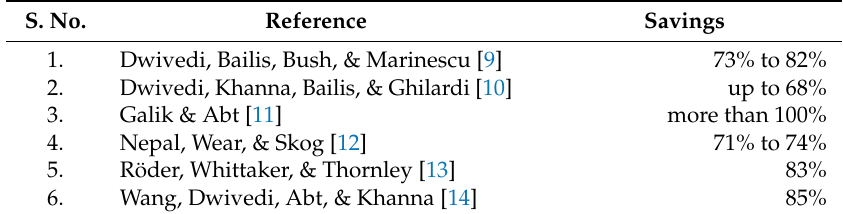
Table 1. Savings in greenhouse gas emissions from electricity derived from wood pellets relative to fossil-fuel based